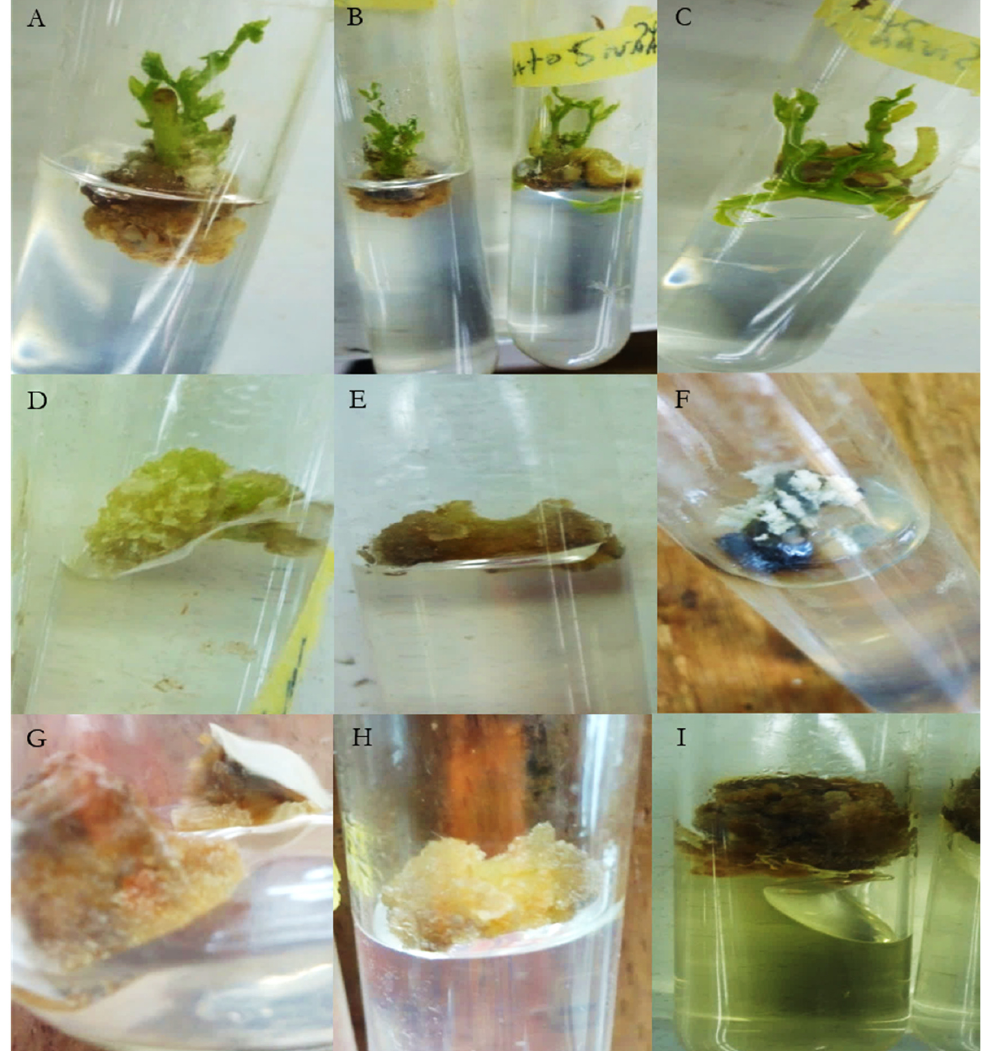
Figure 2(A-I). Shoot and callus formation of in vivo explants of P. erosus 4 weeks after inoculation on MS media + PGR (A) Nodal explants with multiple shoots and basal callus on MS media + 1.0 BA mg/L (B) Nodal explants with multiple shoots and basal callus on MS media + 1.0 mg/L BA + 0.5 mg/L NAA (C) Nodal explants with multiple shoots on MS media + 0.5 mg/L NAA. (D) Stem explants forming friable callus on MS media + 1.0 mg/L BA + 0.5 mg/L NAA. (E) Stem explants forming friable callus on MS media + 0.5 mg/L NAA (F) Stem explants with compact callus on MS media + 0.75 mg/L NAA+ 1.0 mg/L Kin. (G) Tuber explants with friable callus on MS media +